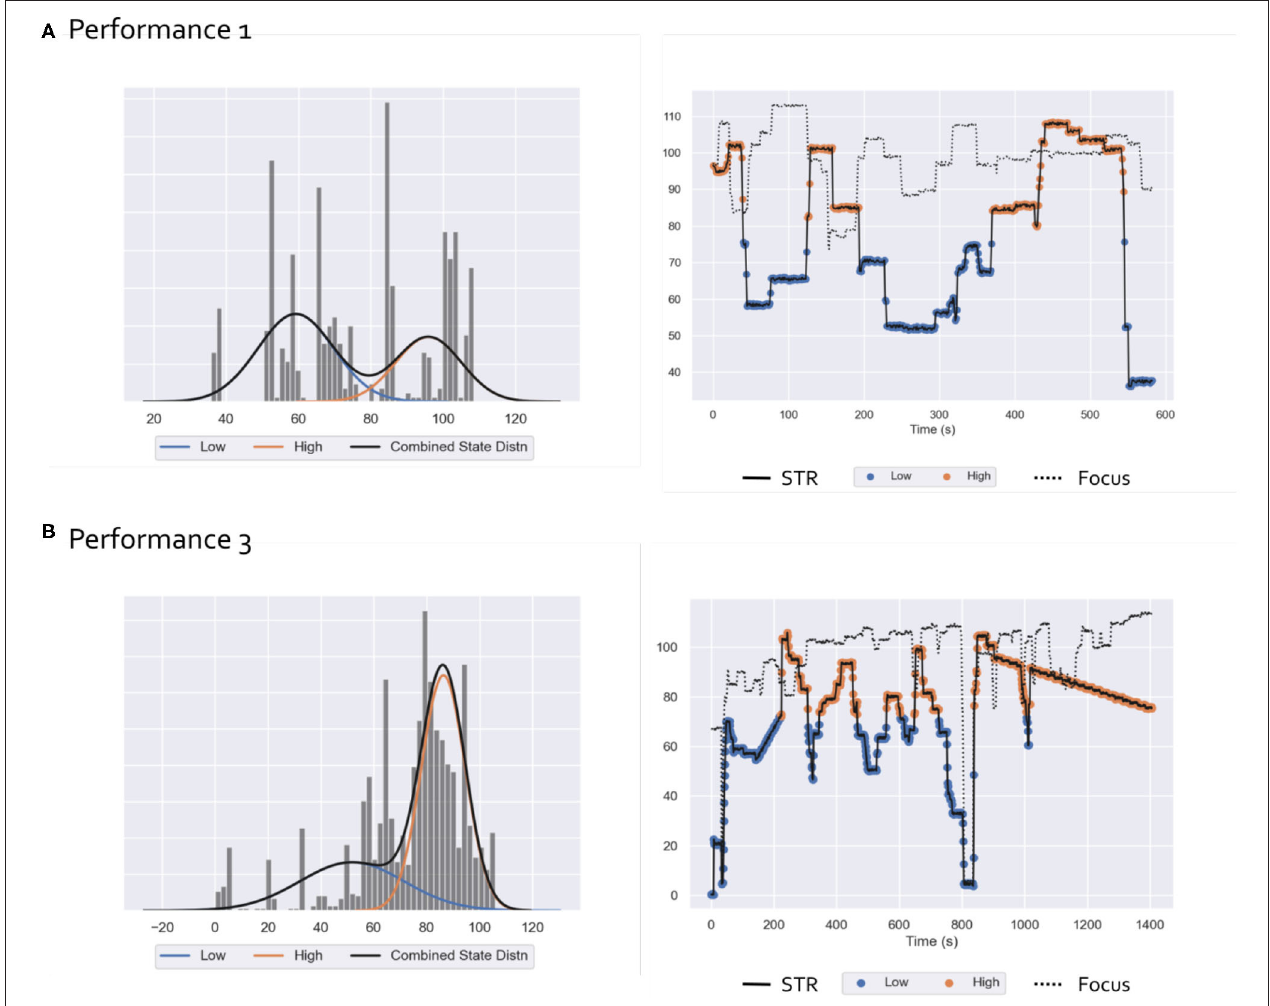
FIGURE 2 | Ecological Paradigm: Results of HMM analysis of subjective rating scores for performance 1 (A) and performance 3 (B) Left: STR samples histograms and distribution (black) as a mixture of low (blue) and high (orange) states Gaussian distributions. Right: STR (solid line) and Focus (dotted line) time-series relative to the performances 1 and 3. For the STR, samples corresponding to the low and high states are labeled with blue and orange markers,